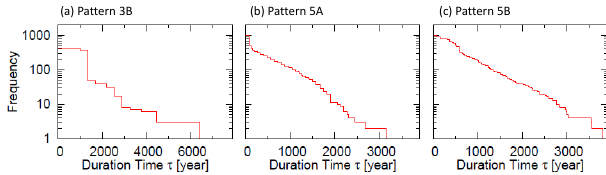
Figure 14. Examples of the variation of recurrence interval T n of slip events at the three blocks for (a)–(c) pattern 3 and (d)–(f) pat- tern 5. The time intervals of the two patterns A and B are indicated by blue and red bars, respectively. The model parameter sets for (a)–(c) and (d)–(f) are the same as those for Figs. 10 and 13, re- spectively.